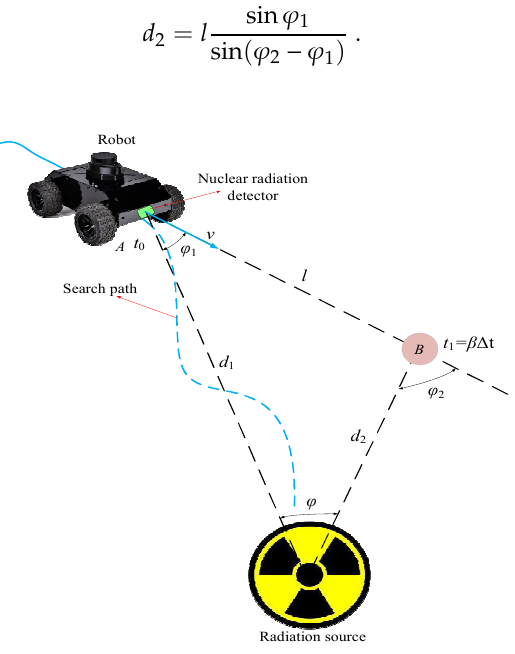
Figure 1. Robot’s radiation measurement model.